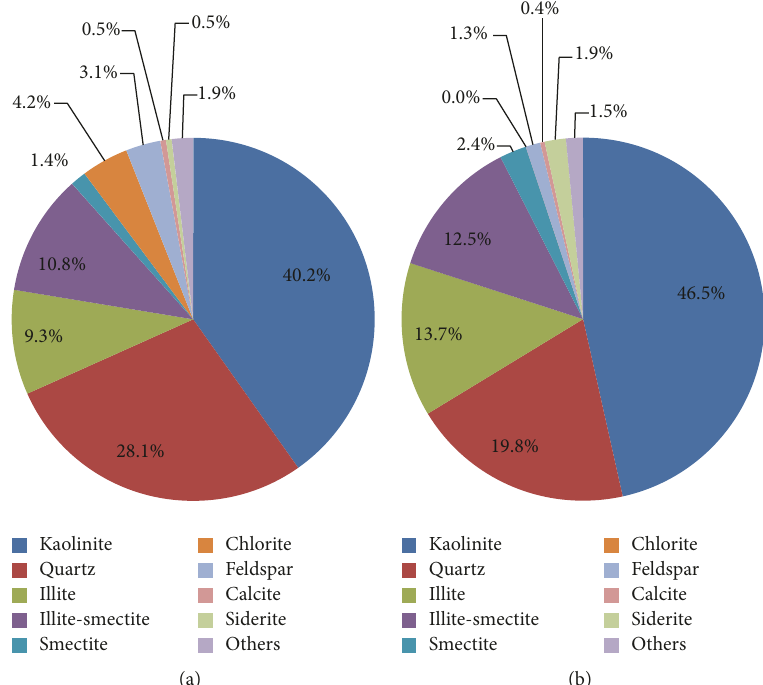
Figure 11: (a) Mineral components of infilling materials for Sample 1; and (b) mineral components of infilling materials for Sample 2.